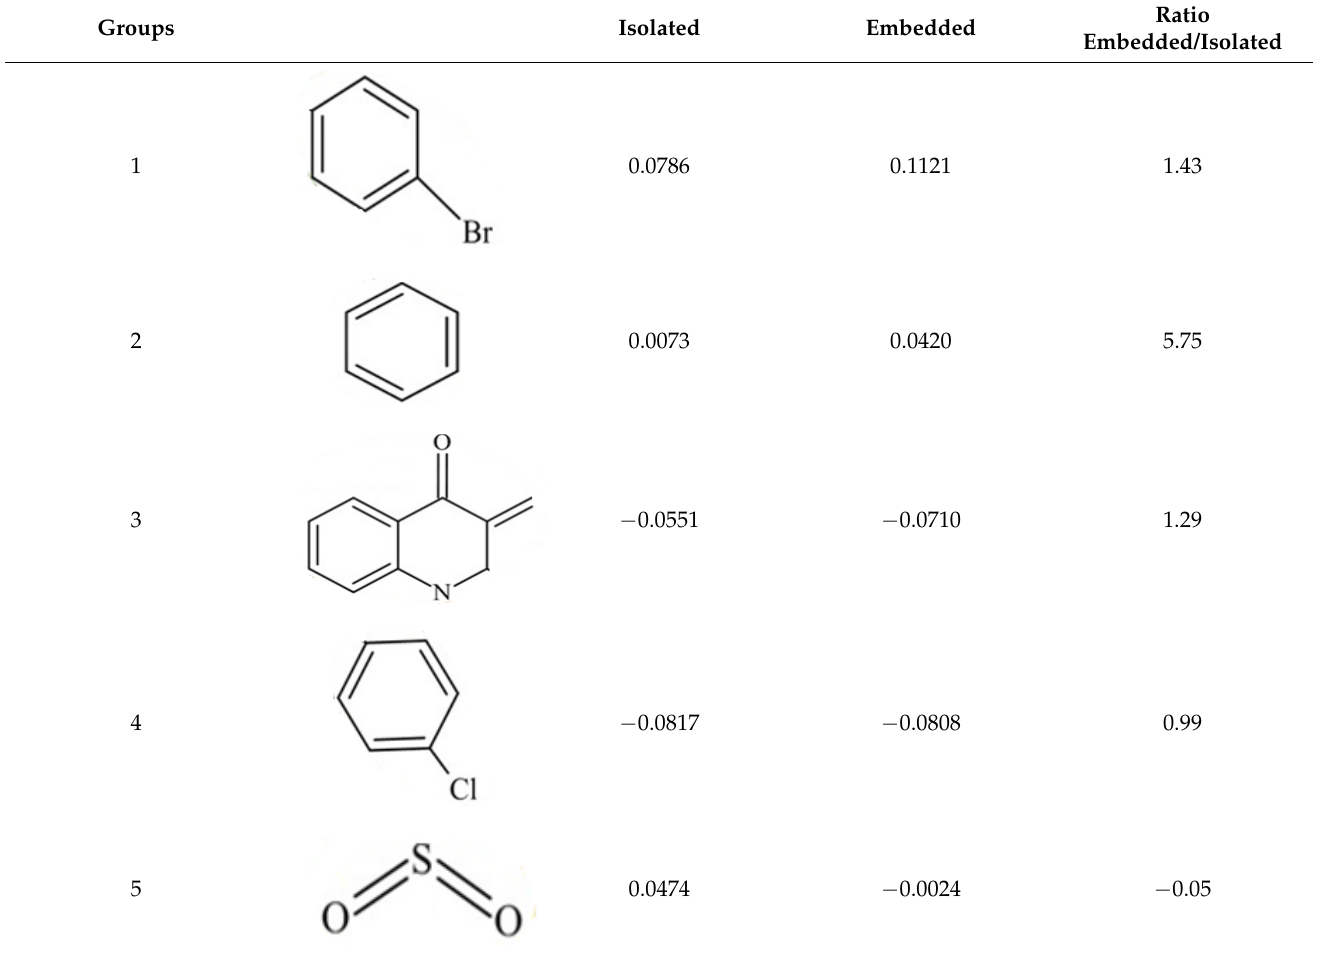
Table 5. Charges (e) of selected groups of the QBCP’s isolated and embedded molecules. Groups